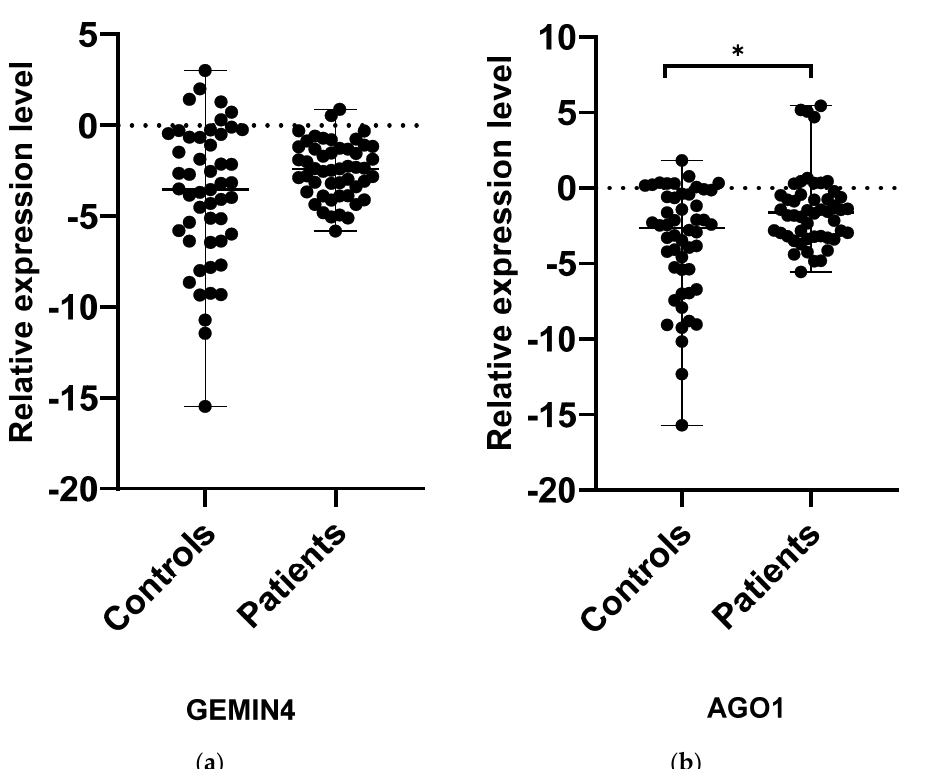
Figure 1. Expression levels of GEMIN4 ( a ) and AGO1 ( b ) in PBMCs from MS patients and healthy controls. Statistical analysis of differences between the groups of data was carried out using the Mann–Whitney U-test (* indicate statistical significance at a p < 0.05).